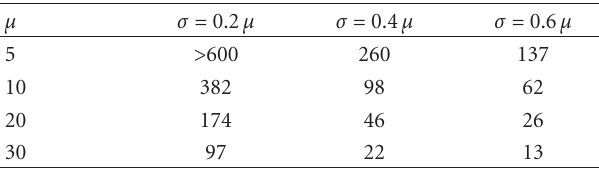
Table 1: Optimal point count (OPC, defined in the methods) for di ff erent mean percent cover values ( μ ) and levels of transect heterogeneity ( μ